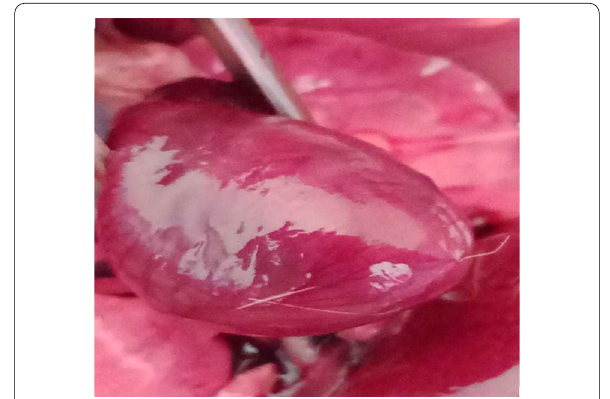
Fig. 1 Macroscopic picture of ISO induced acute myocardial infarction in